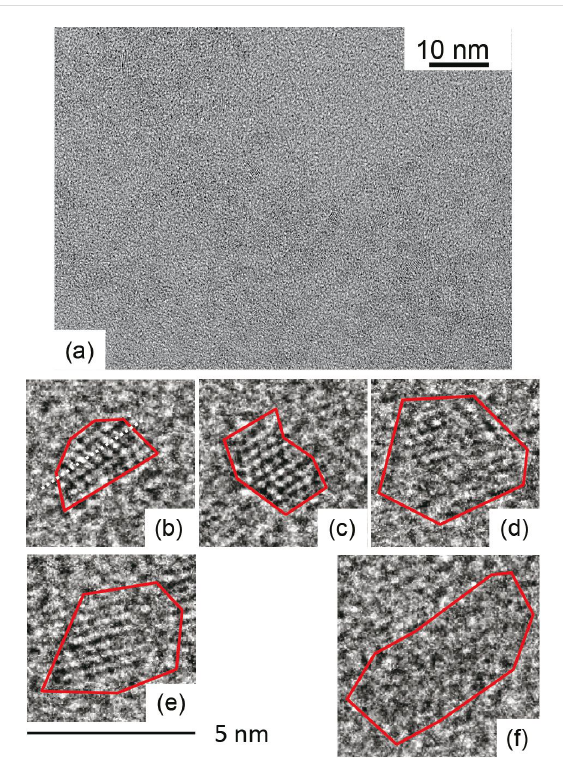
Figure 6: TEM images of ZAIS nanocrystals grown with 532 nm light (400 mW), t = 60 min; (a) low (2,000,000×) and (b–f) high (4,000,000×)